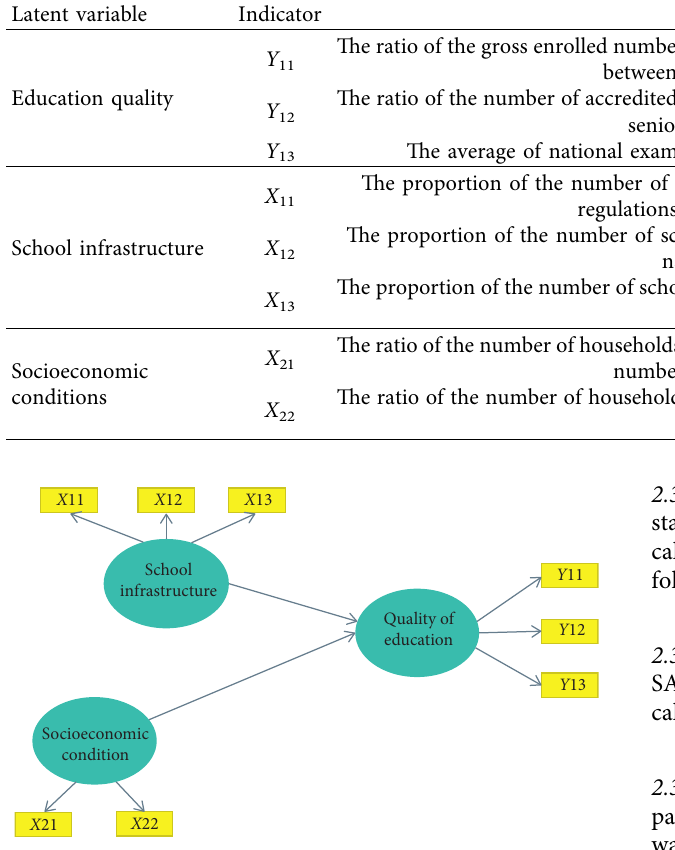
Figure 2: Theoretical hypothetical model of quality of education at senior high